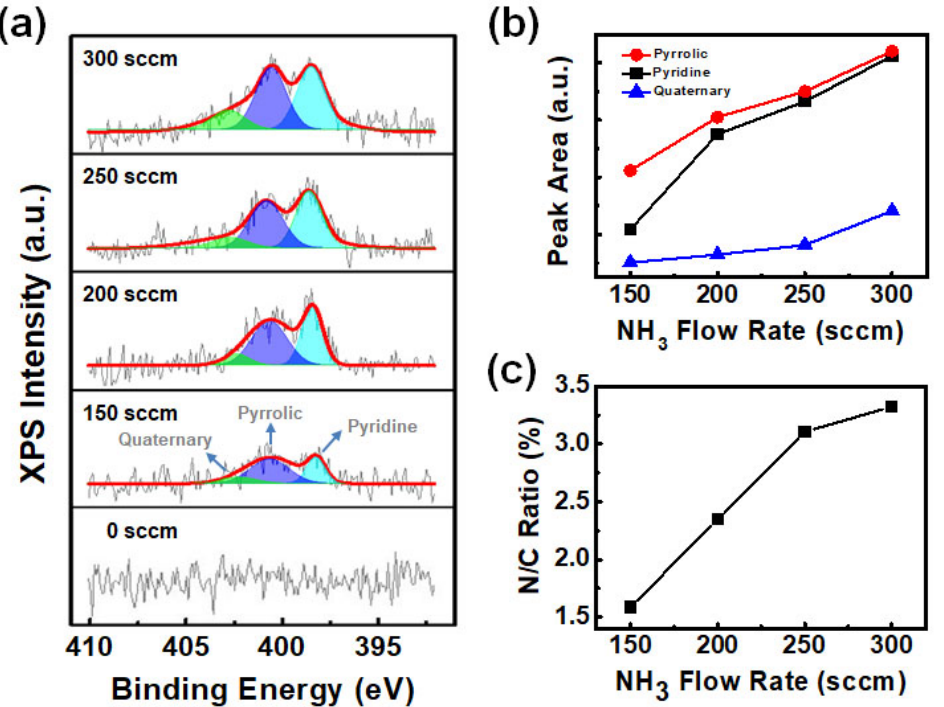
Figure 2. ( a ) N 1 s XPS spectra of the nitrogen-doped Ni-graphene CSNPs, ( b ) peak area according to nitrogen bonding, and ( c ) N/C ratio for different NH 3 flow amounts.